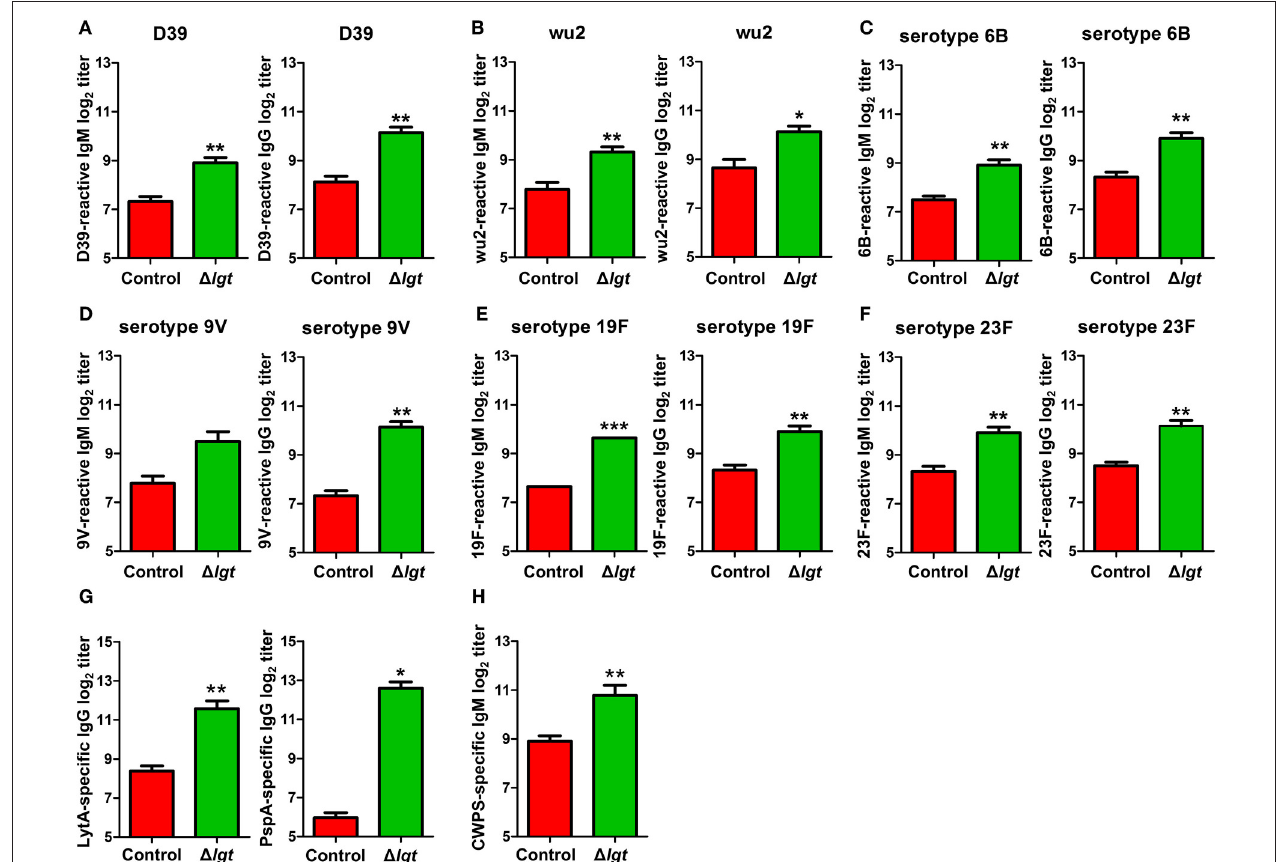
FIGURE 4 | Cross-reactiveantibodyproduction followingimmunization with TIGR4 1 lgt. Serumlevels ofIgMandIgGreactive toserotypes2(D39; A ),3(wu2; B ),6B (C) , 9V (D) ,19F (E) ,and23F (F) andserumlevelsofLytA-,PspA-,andcellwallPS-specificIgG (G,H) weredeterminedat10daysafterthesecondimmunizationinmice( n = 5 per group) i.n. immunized twice with 1 lgt (10 6 CFU) at 14-day intervals. * P < 0.05, ** P < 0.01 and *** P < 0.001 compared with control groups immunized with PBS.